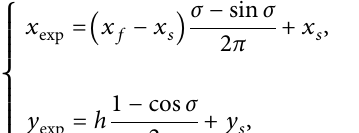
Figure 8: The speed curve of the